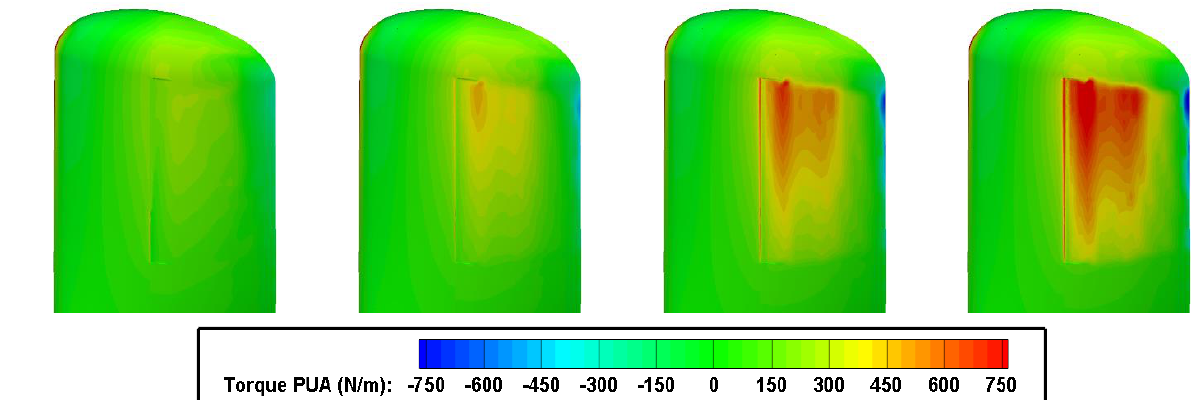
Figure 18. Distribution of torque PUA according to C j for each slit height ( J A = 0.4).